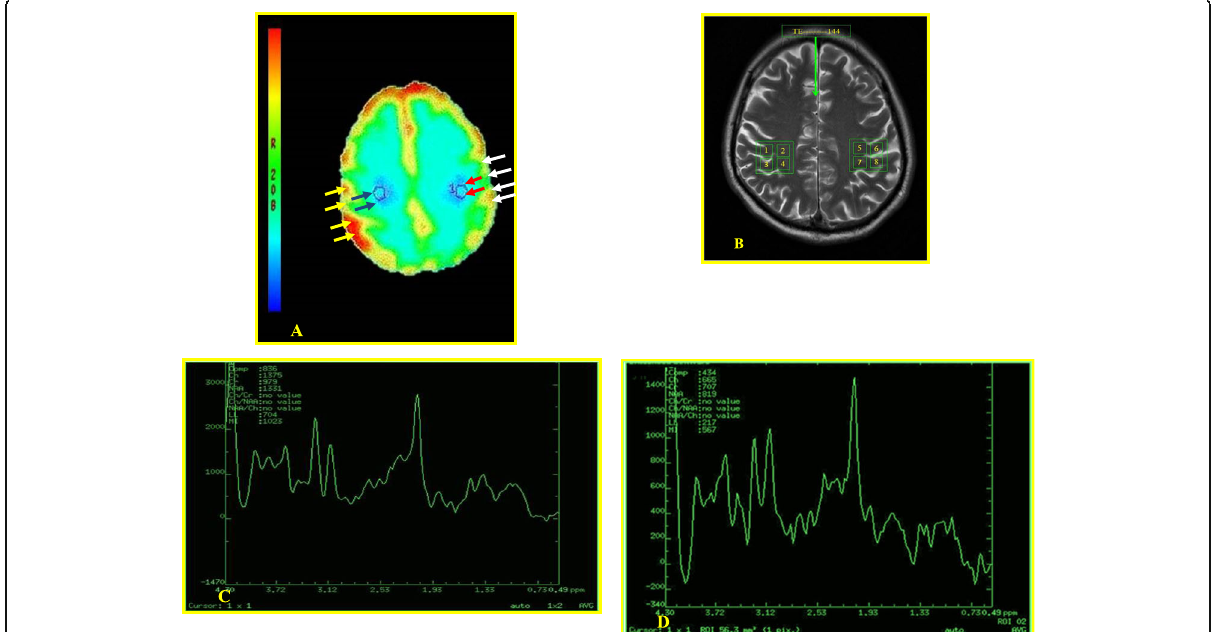
Fig. 6 a – d A 35-year-old female patient with non-lesional left parietal lobe FIAE. The visual-based analysis of the axial PASL-MRI colour-coded cerebral perfusion map ( a ) demonstrated 2 mirrored focal hypoperfusion areas in the right and left parietal lobes, which represented a mirror focus of cerebral area of seizure spread (blue arrows) and the focal epileptogenic zone (red arrows), respectively, and exhibited cool blue colour, according to the colour scale, reflecting the associated decrease in the rCBF. Additionally, based on the colour-coded spectrum, a cortical and subcortical relative hypoperfusion with associated decrease in the rCBF of the left parietal region is seen displaying green and dark yellow colours (white arrows), when compared to the normal perfusion pattern of the corresponding contra-lateral cortical and subcortical right parietal lobe that tinted with red and yellow colours (yellow arrows). The estimated rCBF for the right and left parietal lobes was 78.68 and 57.91 ml/100 g/ min, respectively, with ASLAI% of 30.41%. The MV 1H-MRS picture maps illustrating the studied ROIs of both parietal lobes, were obtained at a long TE of 144 ms ( b ) and short TE of 35 ms. The MV 1H-MRS spectra of the left parietal lobe ( d ) demonstrated the zone of focal epileptogenic activity with increased MI/NAA, Glx/NAA and Glx/Cr, as well as, decreased NAA/(Cho + Cr) ratios, while the MV 1H-MRS spectra of the right parietal lobe ( c ) demonstrated a mirror focus of cerebral area of seizure spread with decreased MI/NA and NAA/(Cho + Cr), as well as increased Glx/NAA and Glx/Cr ratios. For the right and left parietal lobes ( c and d , respectively), these ratios were [NAA/(Cho + Cr) = 0.66 and 0.46 with %AF of 35.71%, MI/NAA = 0.69 and 0.83 with %AF of 18.42%, Glx/ NAA = 1.31 and1.49 with %AF of 12.86% and Glx/Cr = 1.29 and 1.45 with %AF of 11.68%]